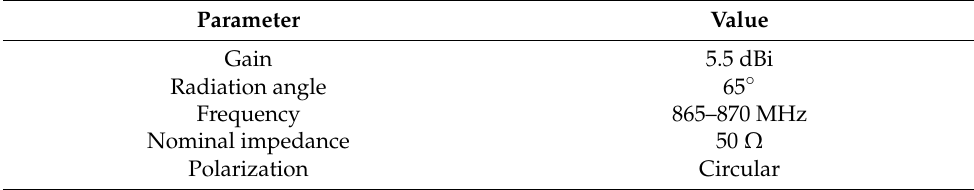
Table 1. Antenna’s parameters.